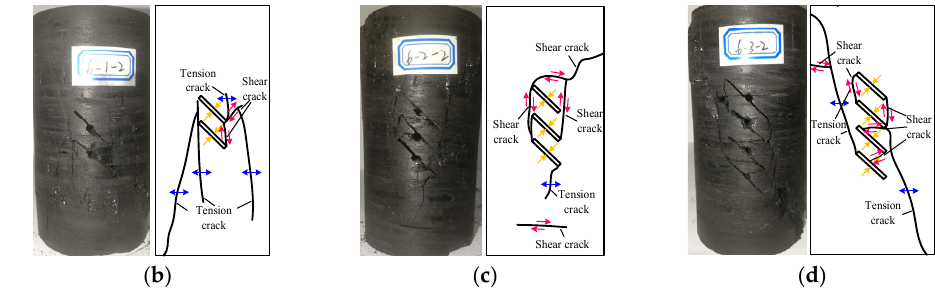
Figure 6. A 0. 3 MPa confining pressure with different numbers of prefabricated cracks in coal spec- imen failure mode and its sketch. ( a ) M-0.3-1; ( b ) M-0.3-2; ( c ) M-0.3-3; ( d ) M-0.3-4.